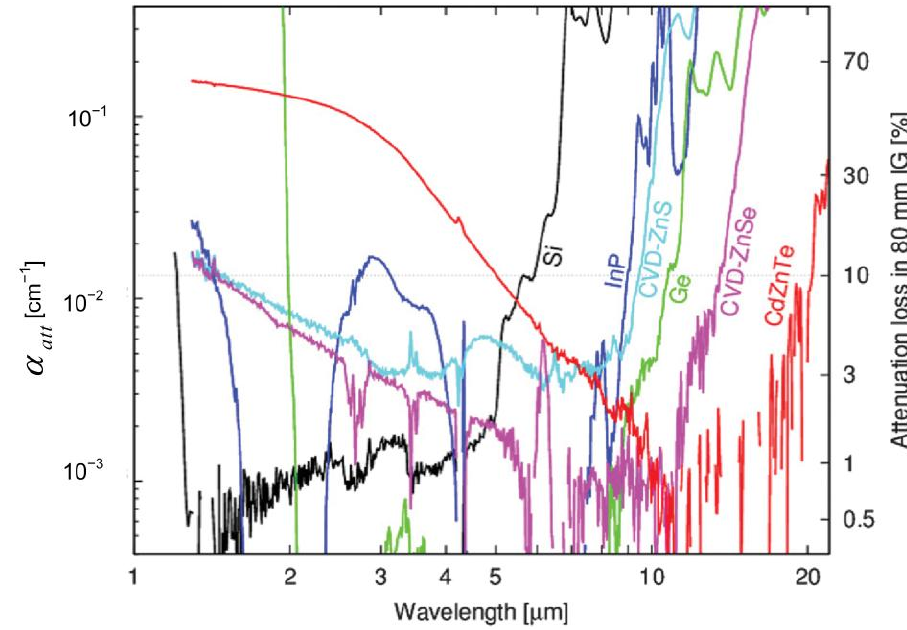
Figure 5. Infrared material properties of candidate infrared materials.